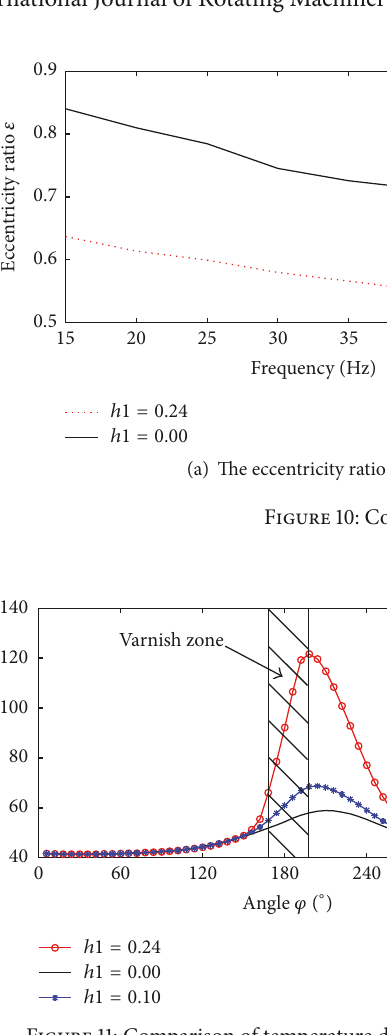
Figure 11: Comparison of temperature distribution.